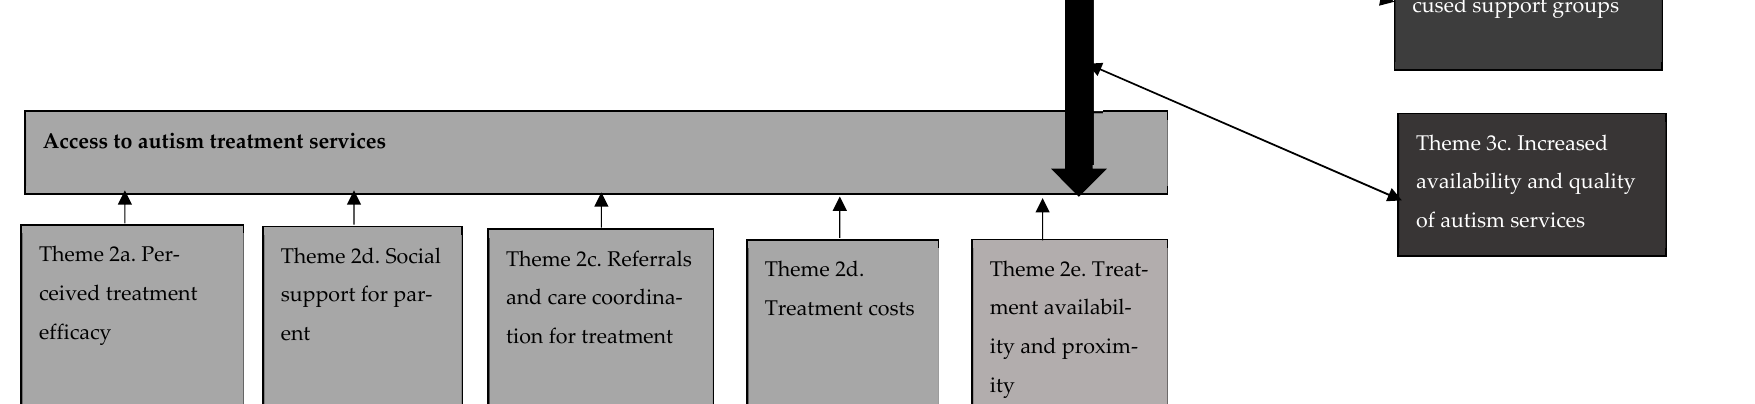
Figure 3. Connections between Themes on Access to Services for Diné Parents of Children with Autism.